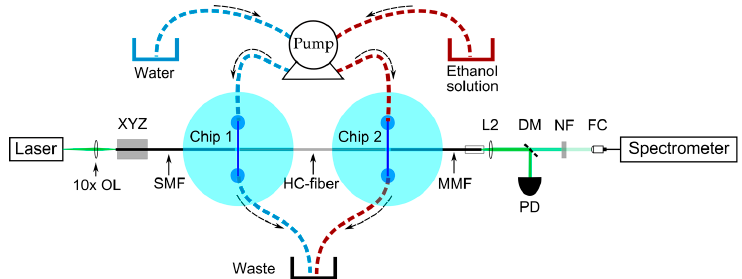
Figure 8. Diagram of optical and fluid system used in the Raman experiments.10× OL: 10× objective lens. XYZ: 3-axis stage for fiber alignment. SMF: single-mode fiber. MMF: multi-mode fiber. L2: lens. DM: dichroic mirror. NF: notch filter. PD: photodetector used to monitor the power. FC: fiber coupler. Dashed-arrows represent the flow direction.